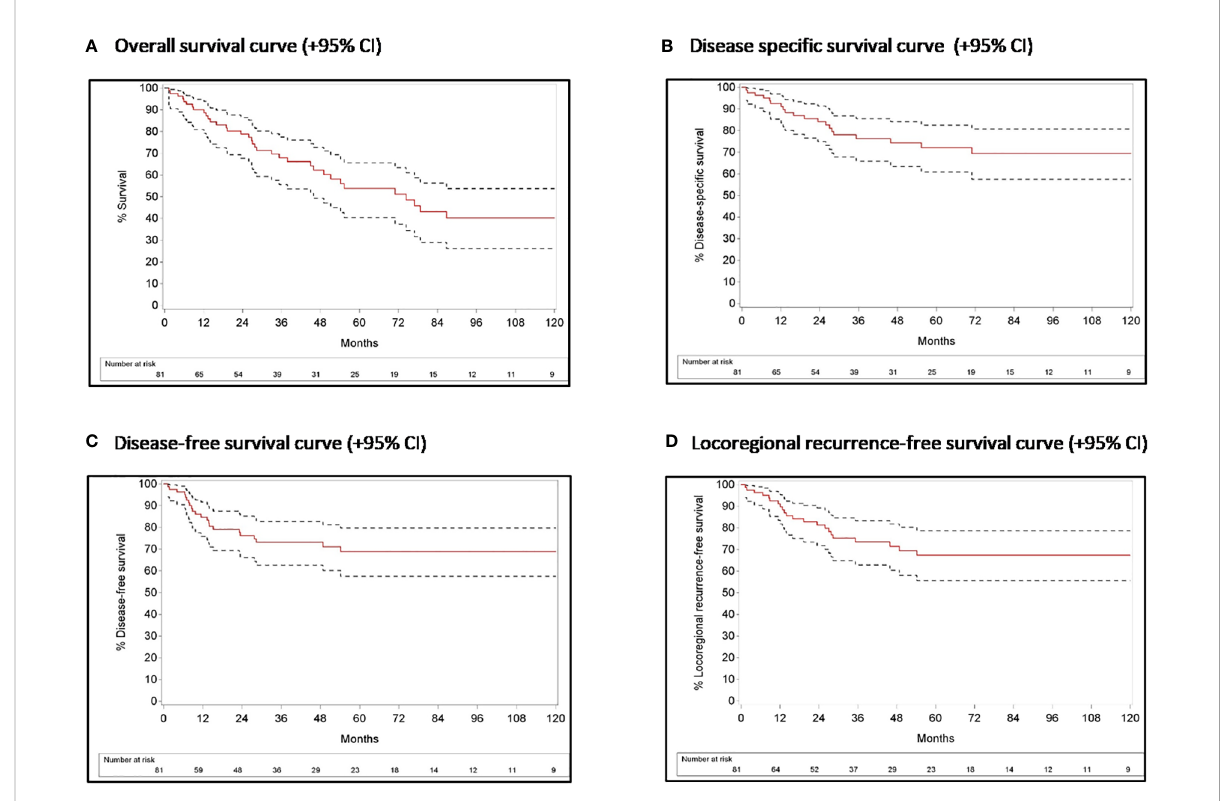
FIGURE 1 Survival curves with 95% con fi dence interval for the overall patient